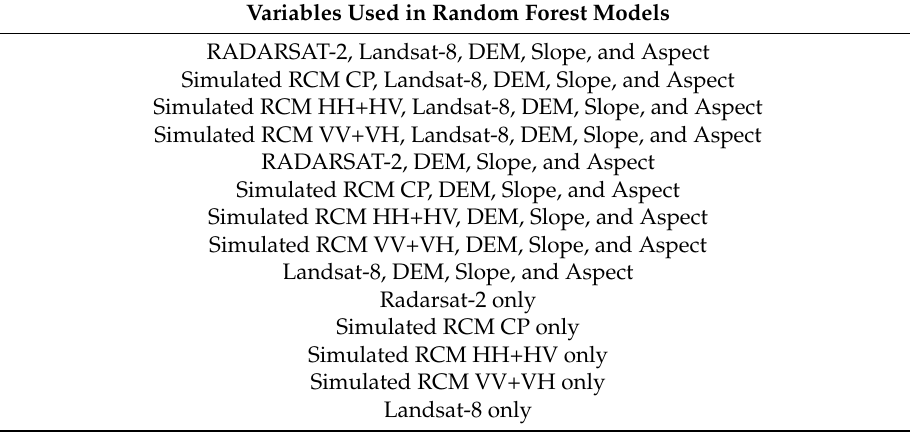
Table 3. Combinations of variables used in the RF mapping of landcover within peatlands. Each of the 14 models was first run using a spring RADARSAT-2, simulated RCM, and/or Landsat-8 image. All models were re-run using a summer RADARSAT-2, simulated RCM, and/or Landssat-8 image. For models that used simulated RCM data as predictor variables the models were first run with a NESZ of − 19 dB, and a second time with a NESZ of − 25